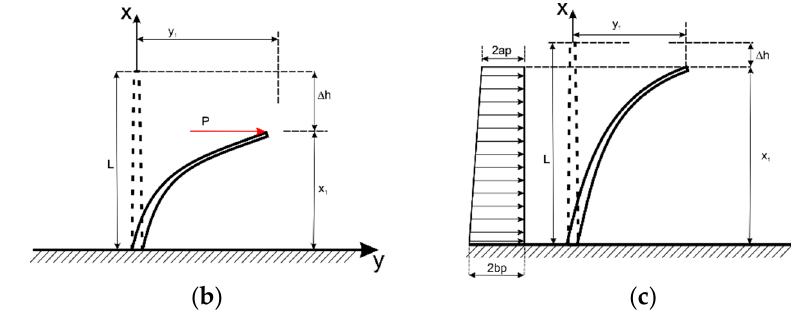
Figure 5. Calculation scheme of ( a ) small stem/branch truncated cone deflection loaded by hydrodynamic pressure ( b ) large stem/branch truncated cone or cylinder deflection loaded by concentrated force ( c ) large stem/branch truncated cone deflection loaded by hydrodynamic pressure (author’s figure based on [31], explanations in text).